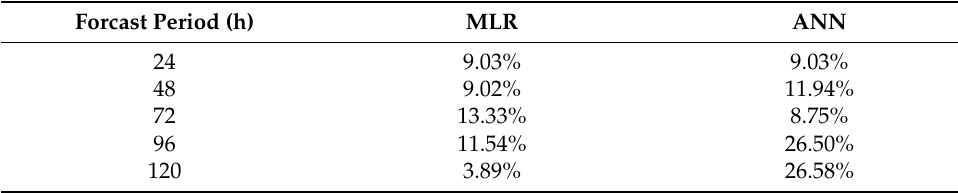
Table 4. The improvement of the combined model compared to the single model. Forcast Period